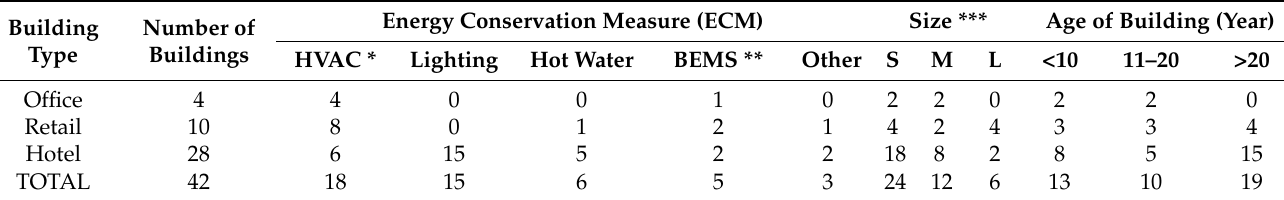
Table 1. Summary of energy efficiency retrofit case